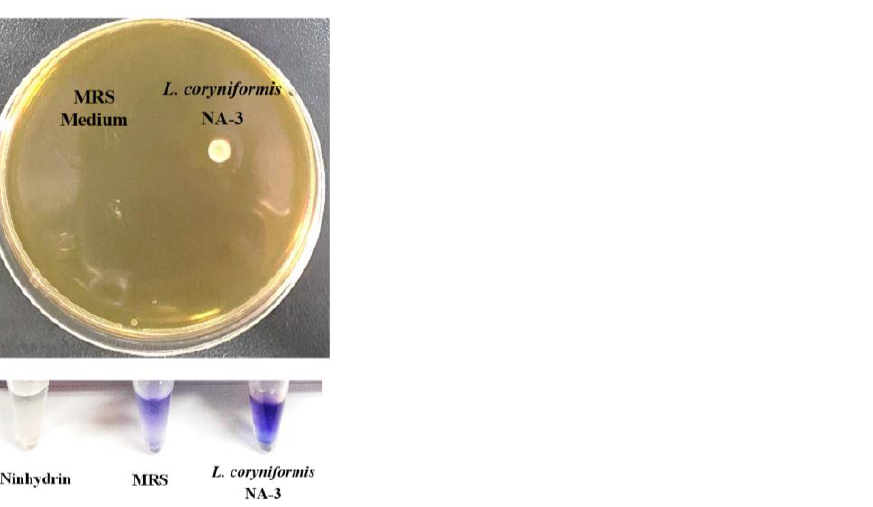
Figure 3. Result of cholesterol removal and bile salt hydrolase production of Loigolactobacillus coryniformis NA-3. ( a ) White sediment appeared when L. coryniformis NA-3 was grown on a medium supplemented with cholesterol. ( b ) The color reaction of white sediment and ninhydrin was obviously bluish-violet and darker than ninhydrin solution and MRS broth, indicating enzyme production.